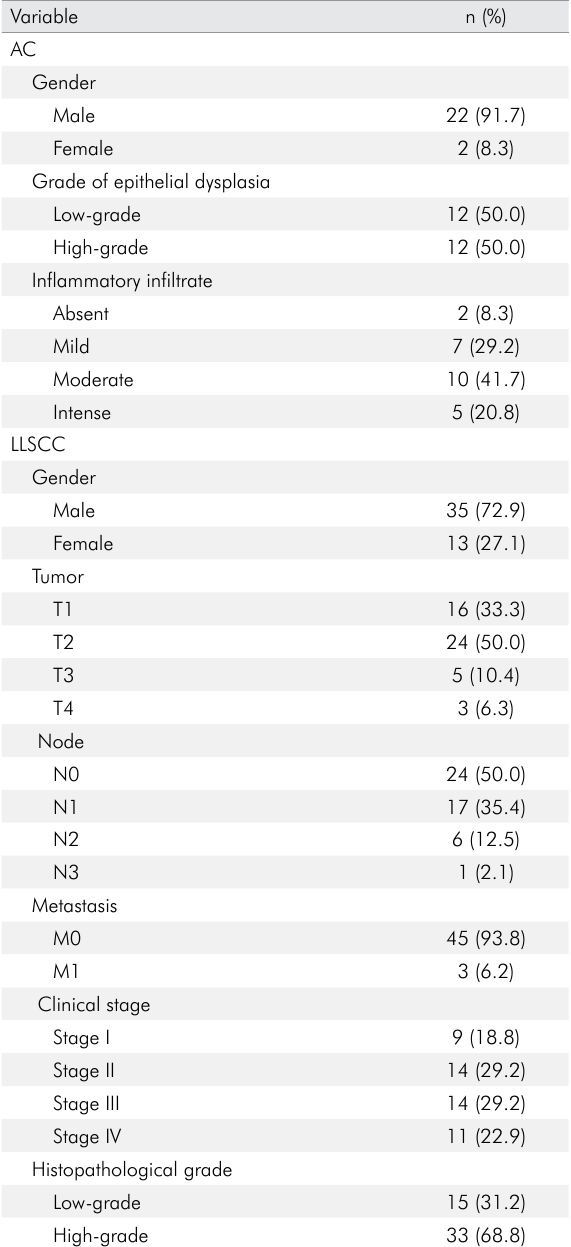
Table. Distribution of cases of AC and LLSCC according to clinicopathological